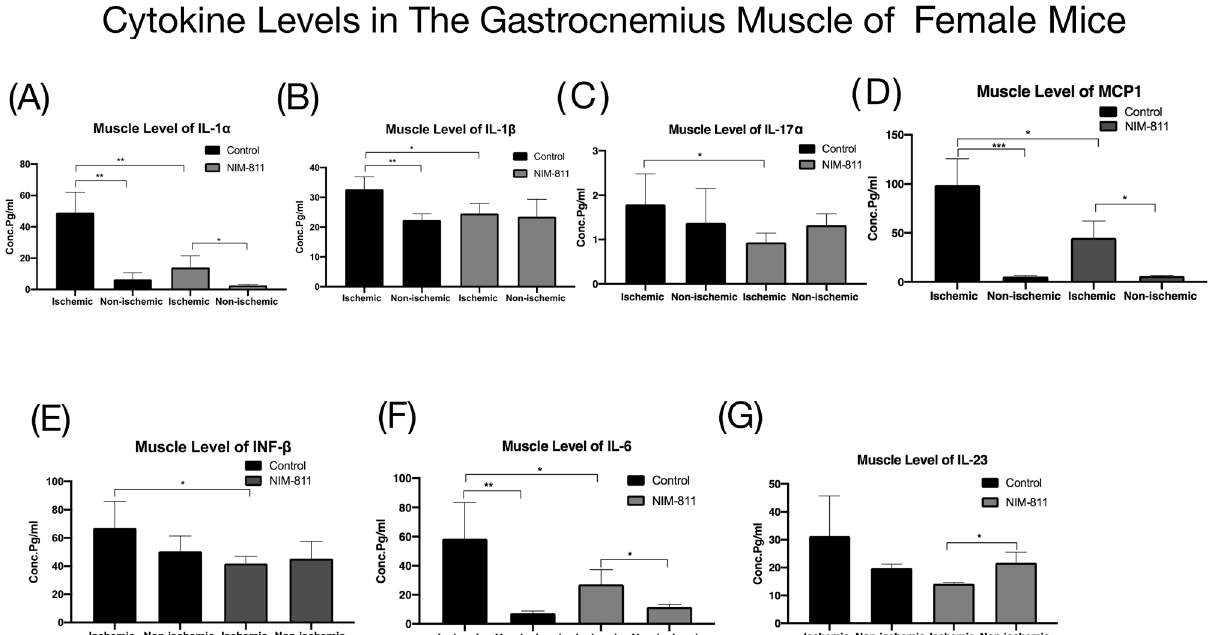
Figure 7. Tissue cytokine levels in female mice after hindlimb ischemia–reperfusion and treatment with NIM- 811. ( A – F ) Tissue IL-1α, IL-1β, IL-17α, MCP 1, INF-β, and IL-6 levels decreased significantly in the ischemic muscle of female mice treated with NIM-811 compared to the ischemic muscle of the control group. ( G ) Tissue IL-23 level decreased significantly in the ischemic muscle of female mice treated with NIM-811 compared to the non-ischemic muscle of the same group. ***P < 0.001, **P < 0.01 and *P <